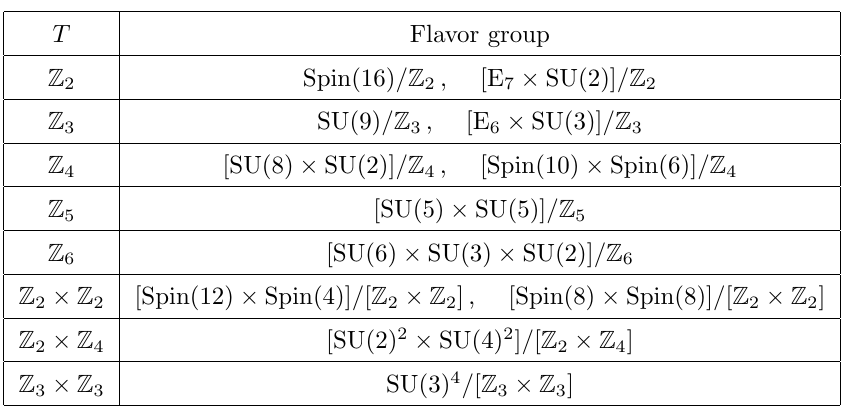
Table 2 . Flavor groups of E 8 discrete holonomy instanton. The surviving (cid:13)avor group is given by the centralizer of the discrete subgroup in E 8